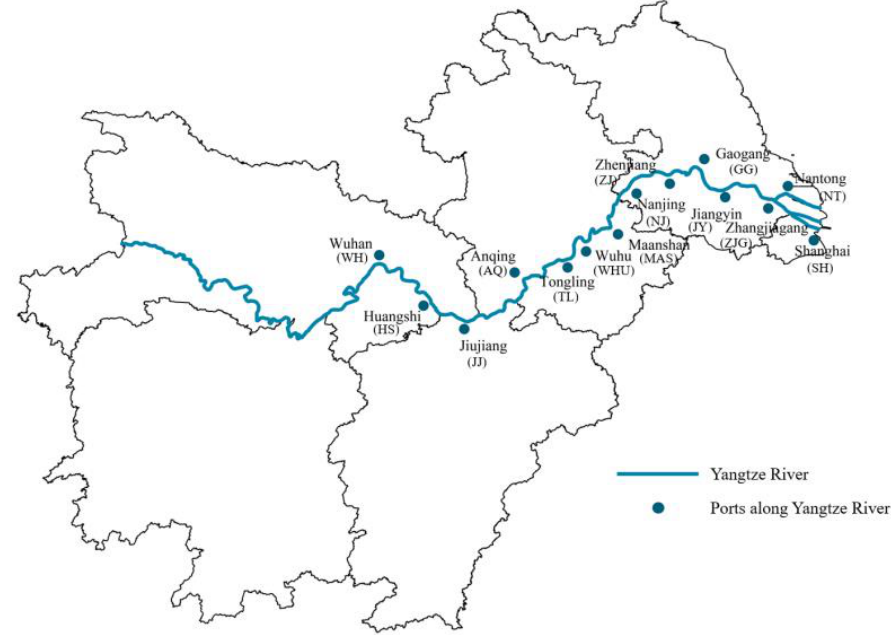
Figure 2. A shipping network along the Yangtze River. Table 3. Shipping routes along the Yangtze River.